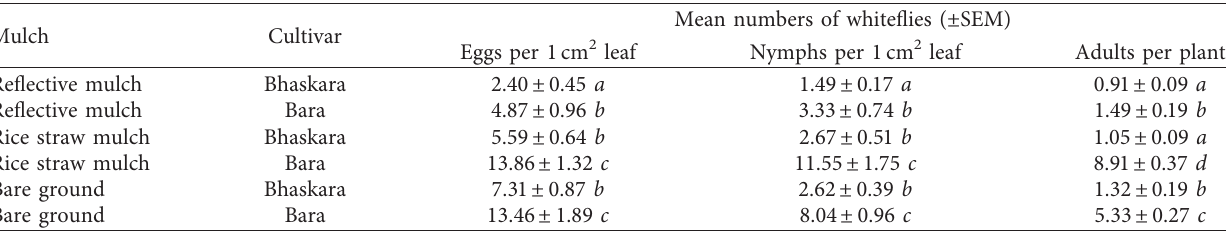
Table 5: Influence of mulch and cultivar treatments on the average numbers of whitefly eggs, nymphs, and adults across insecticide treatments, 2019.